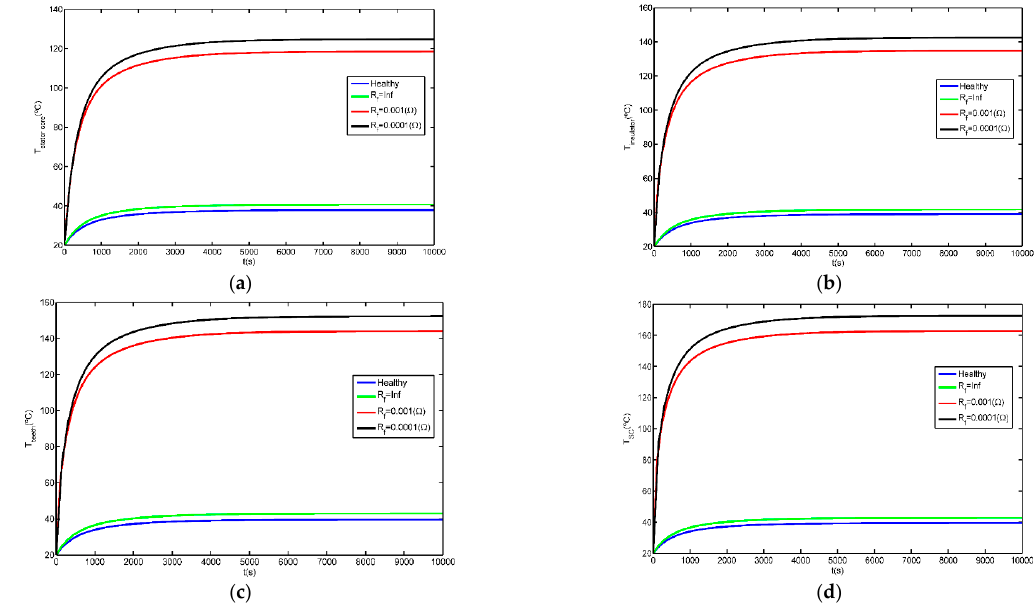
Figure 8. Measured temperatures: ( a ) stator core, ( b ) insulator, ( c ) stator teeth, and ( d ) short-circuited C19 coil.